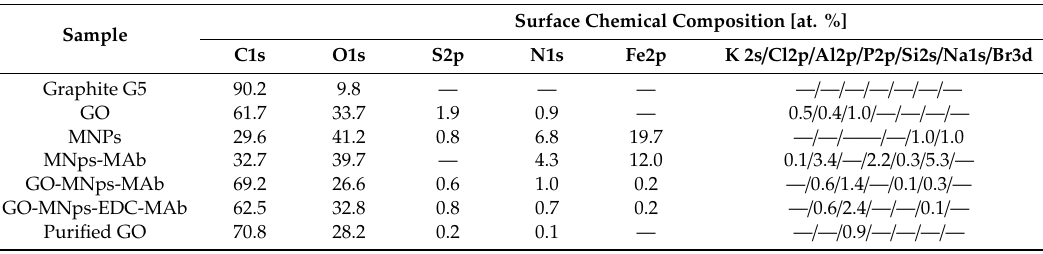
Table 1. X-ray photoelectron spectroscopy analysis of graphite, GO and purified GO.